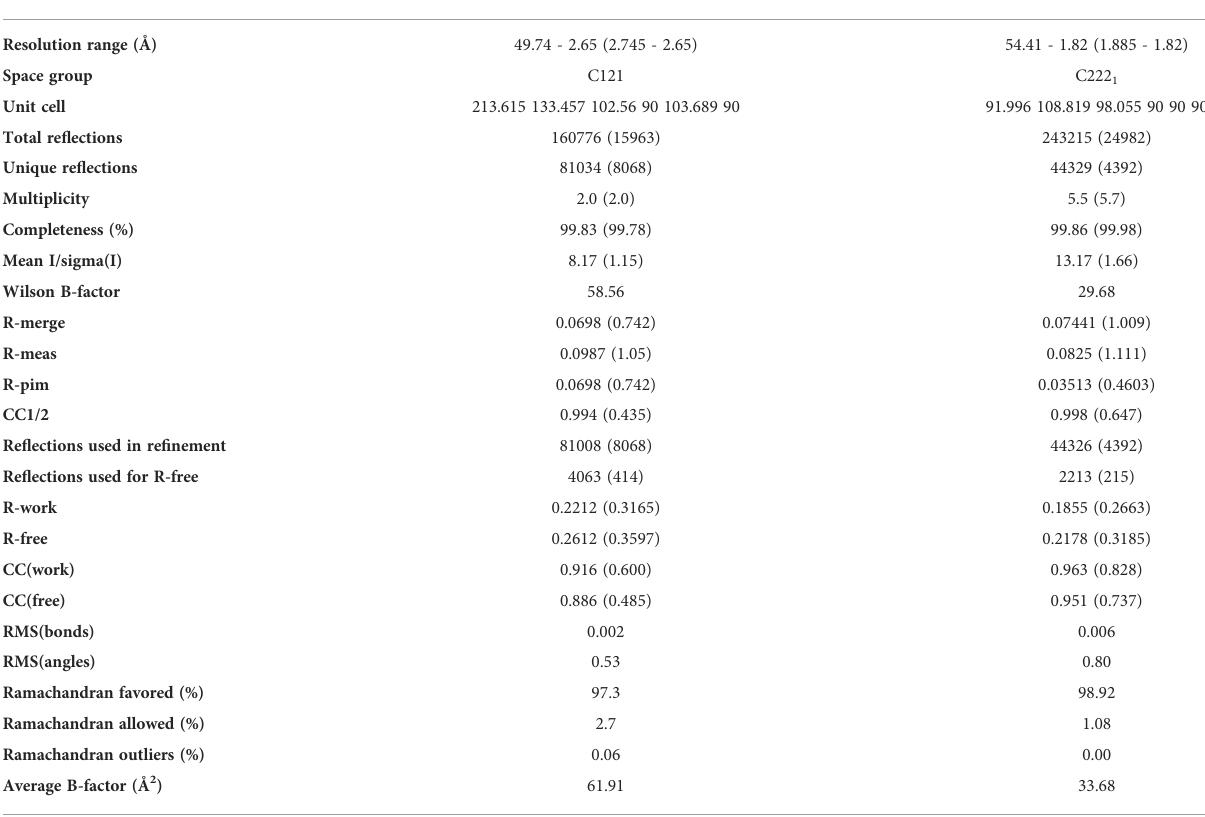
TABLE 1 Diffraction data collection and re fi nement